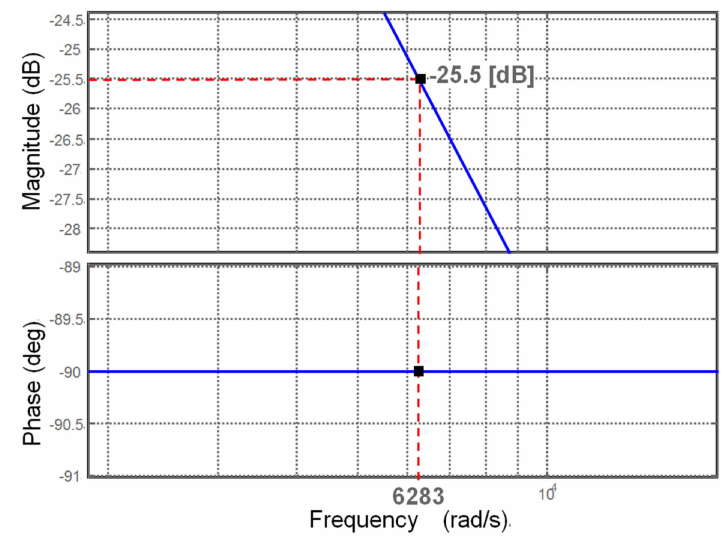
Figure 9. Bode plot for current control.